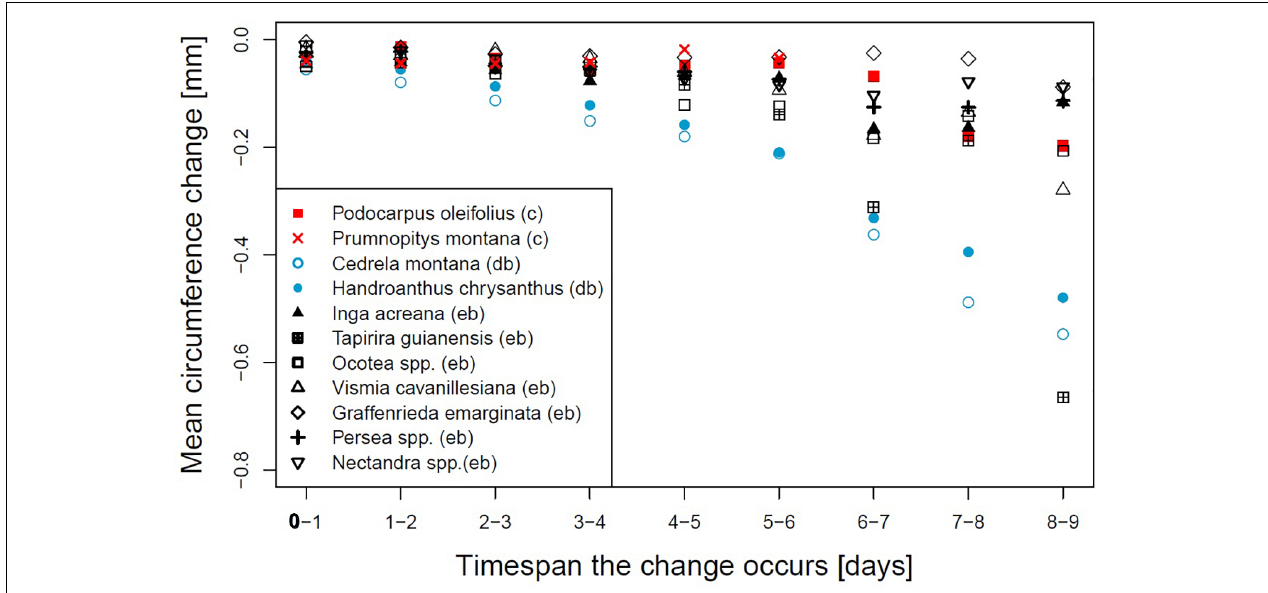
FIGURE 2 | Daily mean circumference change on subsequent days for different genera or species. Evergreen broadleaved (eb, black), coniferous (c, red) or deciduous broadleaved (db, lightblue).